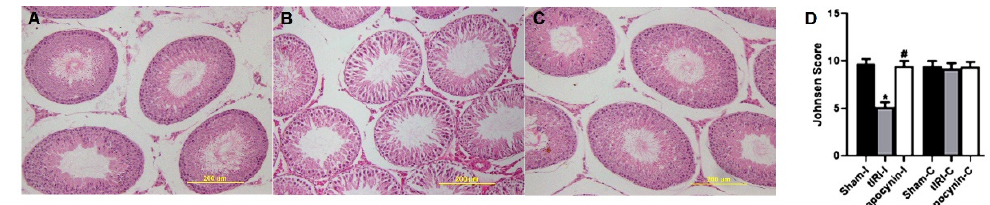
Figure 5. NOX promotes spermatogenic arrest. H&E-stained testicular tissue sections for ( A ) sham, ( B ) tIRI and ( C ) tIRI + apocynin groups were histologically analyzed for spermatogenesis and ( D ) scored using the Johnson score. The tIRI group exhibited impaired spermatogenesis in comparison to sham and apocynin-treated groups that showed normal spermatogenesis. * tIRI compared to sham and # apocynin-treated compared to tIRI. Apo = Apocynin, I = Ipsilateral, C = Contralateral.4. Discussion.